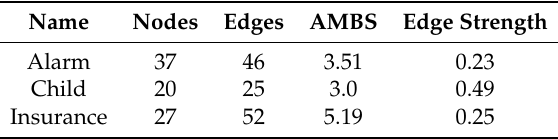
Table 1. Bayesian